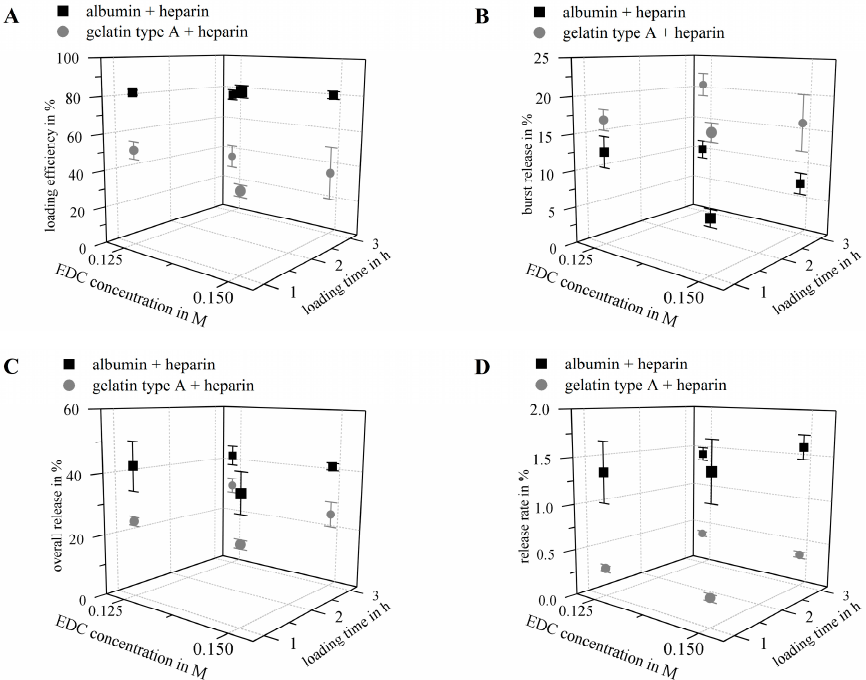
Figure 7. Results of key parameters for the release properties. Hydrogels were prepared with gelatin type A (10 wt %) or albumin (10 wt %) and heparin (1 wt %). For each composition, two EDC concentrations (0.125 M and 0.15 M) were used and hydrogels were loaded by swelling for 1 or 3 h in VEGF solution (1 µg VEGF per mL; loading with 0.1 µg VEGF per mg hydrogel dry weight). VEGF concentrations were normalized to the total VEGF amount used for hydrogel loading ( n = 3). ( A ) Loading efficiency: albumin hydrogels had a higher loading efficiency compared to gelatin type A hydrogels ( p < 0.001). For both hydrogel types the loading efficiency showed a negative correlation with the loading time ( p < 0.01); ( B ) Burst release (release within 24 h): gelatin type A hydrogels had a higher burst release compared to albumin gels ( p < 0.001). For albumin hydrogels, crosslinker concentration showed a negative correlation with the burst release ( p < 0.01); ( C ) Cumulative overall release after 21 days: was higher for albumin gels compared to gelatin gels ( p < 0.001); ( D ) Average release rate between day 7 and day 21: release rates of all albumin gels were significantly higher compared to the corresponding gelatin type A-based gel ( p < 0.001).